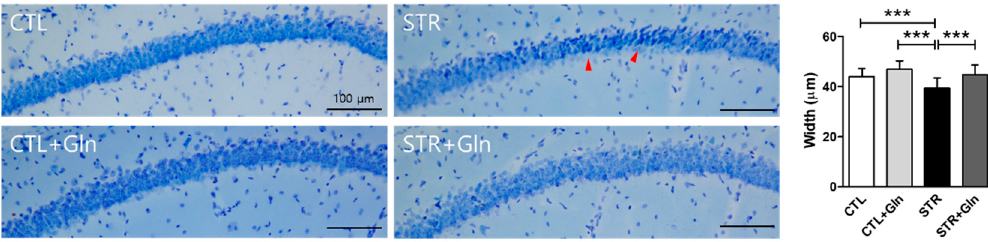
Figure 3. Glutamine (Gln) supplementation prevents chronic immobilization stress-induced morphological changes in the hippocampus. The width of the stratum pyramidale CA1 in the hippocampus was measured on Nissl-stained brain slides. Red arrows indicate small and darkly stained cells. Scale bars = 100 μ m. The bar charts represent means ± SDs. * p < 0.05, ** p < 0.01, and *** p < 0.001 values in a one-way analysis of variance followed by Newman–Keuls multiple-comparison tests ( n = 16/group). CTL, control; CTL+Gln, Gln-supplemented control; STR, stressed; STR+Gln, Gln- supplemented stressed.